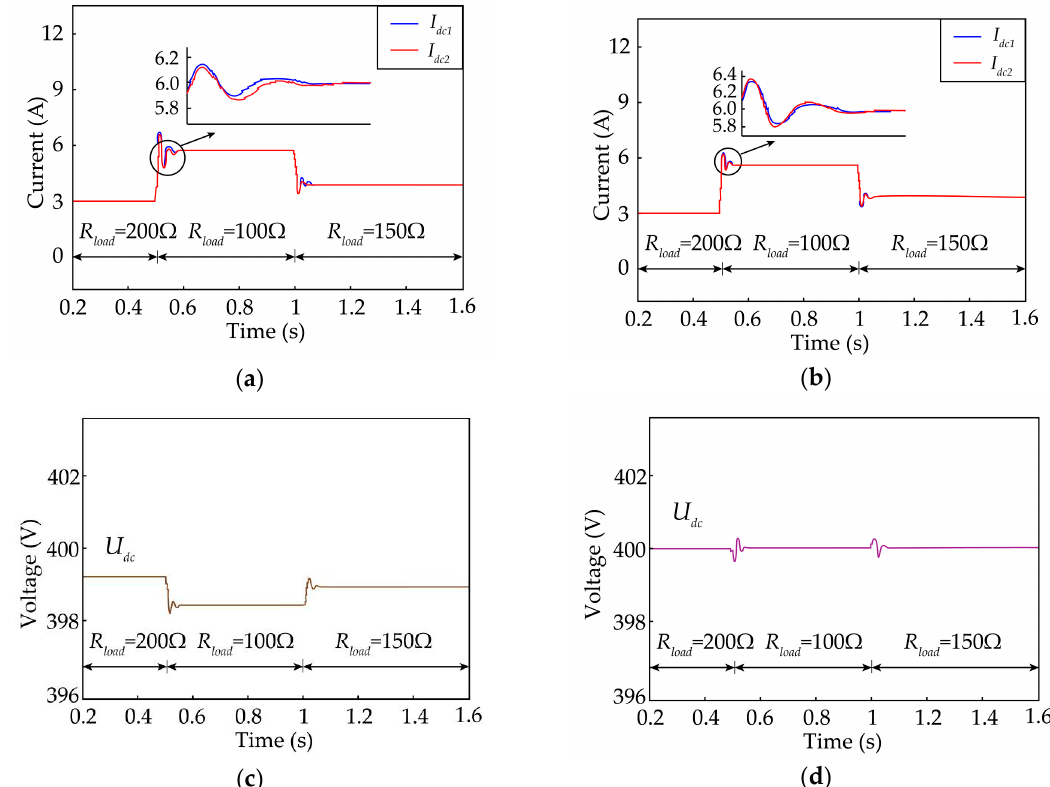
Figure 14. Simulation results of Case 1. ( a ) The current distribution under the traditional algorithm; ( b ) the current distribution under the proposed algorithm; ( c ) the bus voltage under the traditional algorithm; ( d ) the bus voltage under the proposed algorithm.